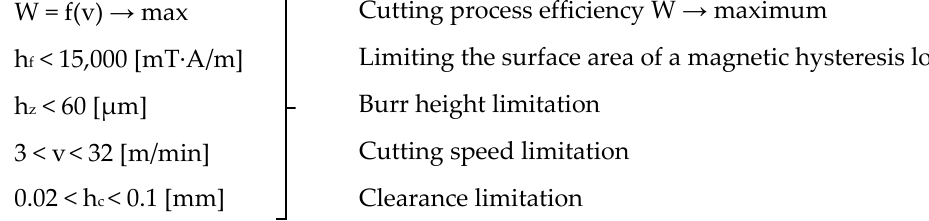
Cutting process efficiency W →